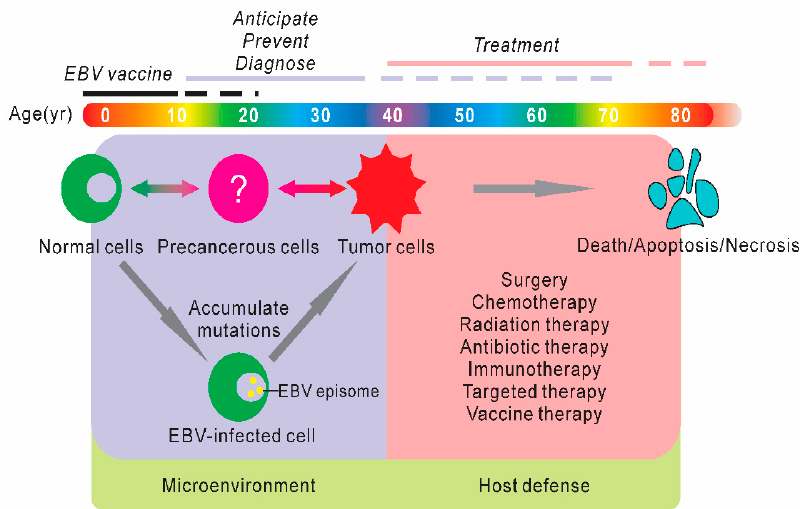
Figure 1. Schematic diagram of the representative protective or therapeutic strategies in development for Epstein-Barr virus (EBV)-associated diseases. EBV vaccination is always a high priority for children under 10 years old and there are no available commercial EBV vaccines. The morbidity and mortality of EBV-associated diseases are relatively low among young adults, so the first strategy is to anticipate, prevent, and diagnose the potential lymphomas. The majority of patients with EBV-associated lymphomas are more than 35 years old, and multiple approaches, including EBV-targeted therapies, are applied to treat these lymphomas. Although EBV is not able to induce the related lymphomas, it can play a critical role in the induction of a multistep process to carcinogenesis through accumulating mutations, in addition to other cofactors. These processes are highly associated with activities in the microenvironment and the host defense.